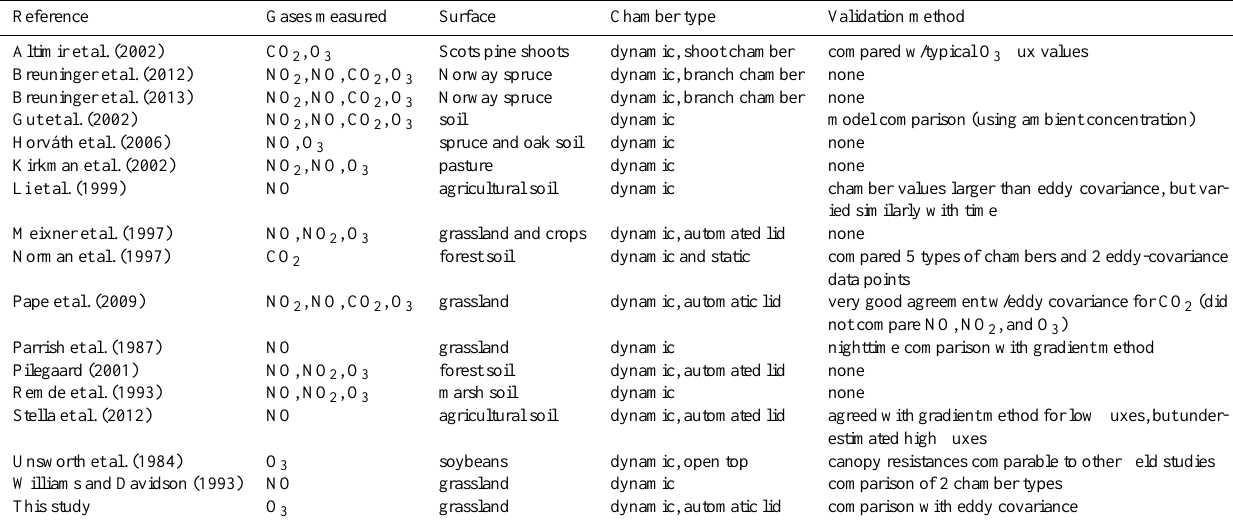
Table 1. Summary of selected chamber measurements of NO 2 , NO, O 3 , and CO 2 .